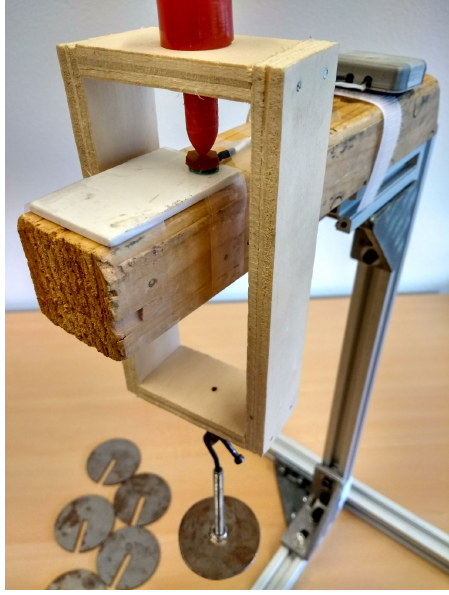
Figure 4. Calibration rig. Each sensor was placed in the calibration rig. Steel disks of 100 g each (bottom left) were placed on the hanger to apply a